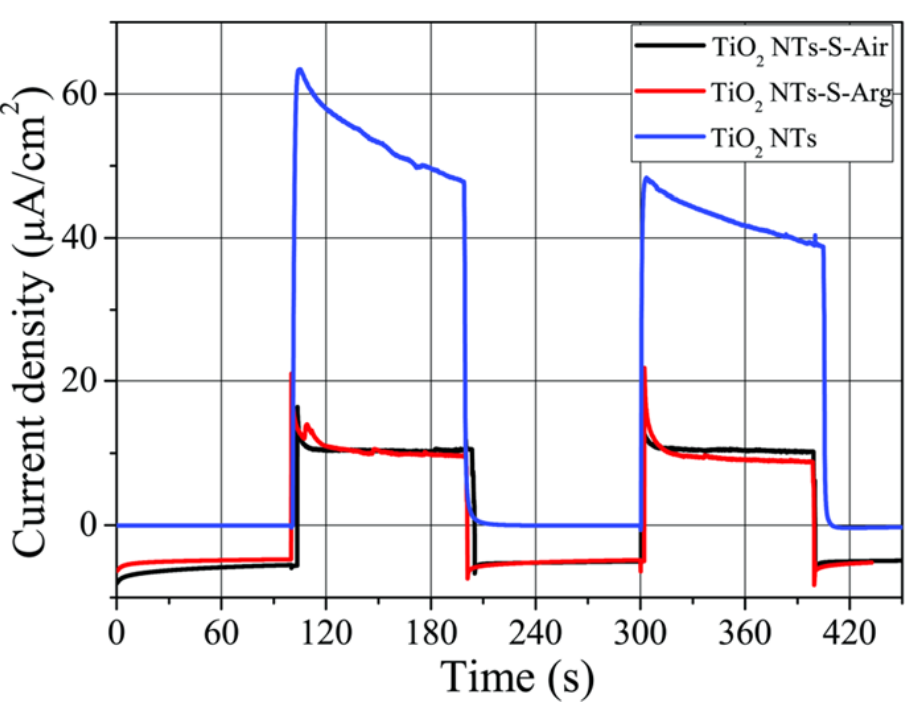
Figure 5. Photocurrent density kinetics of the samples annealed in different media and illuminated by visible light with a wavelength of more than 430 nm.